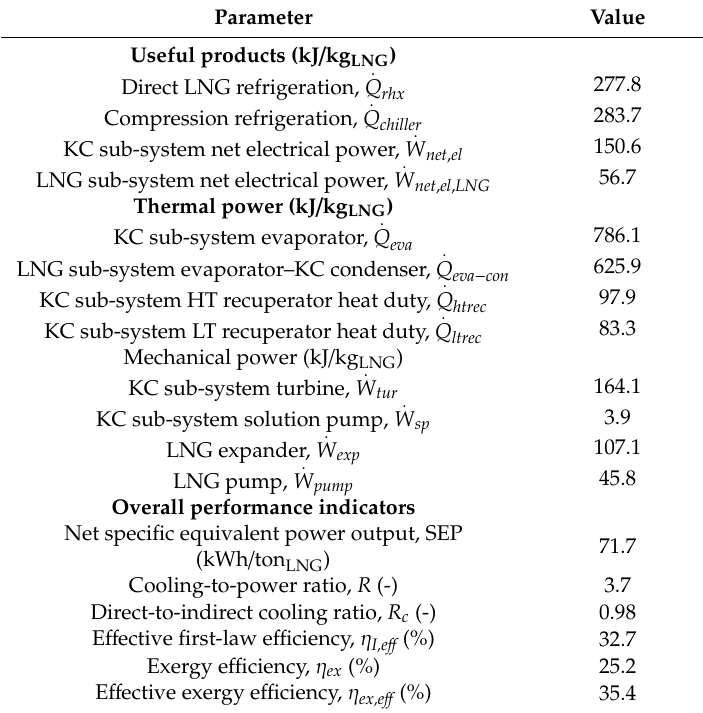
Table 4. Stream thermodynamic properties for the poly-generation system (Figure 1) at nominal conditions. Stream